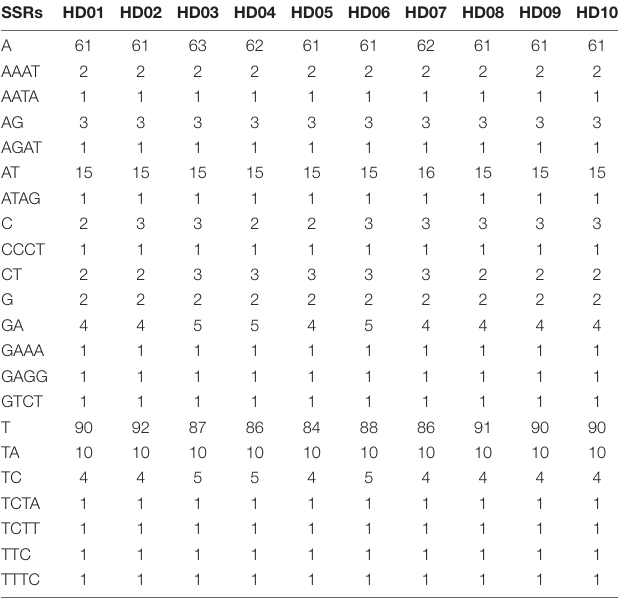
TABLE 8 | Unique Simple sequence repeats (SSRs) in the chloroplast genome (cpDNA) of different samples. SSR